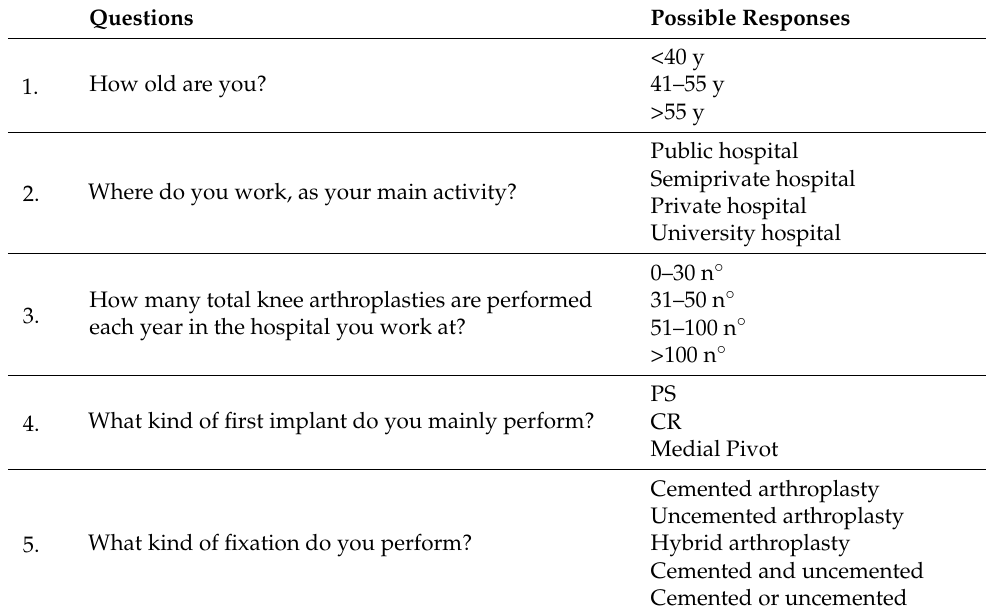
Table 1. Questions asked and possible responses.